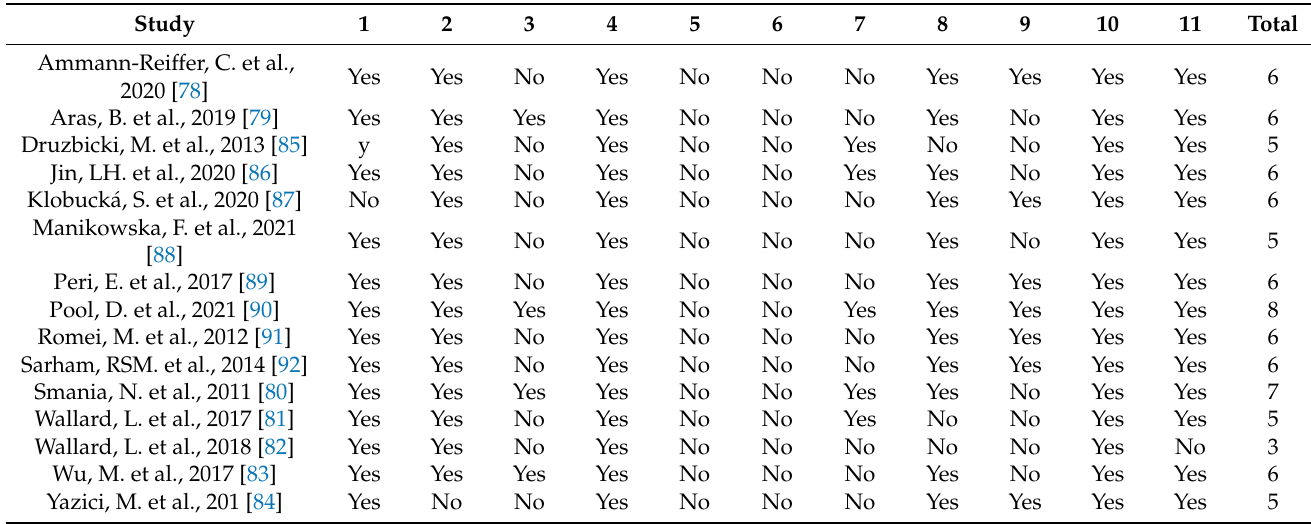
Table 4. Results of methodological quality and risk of bias on the PEDro